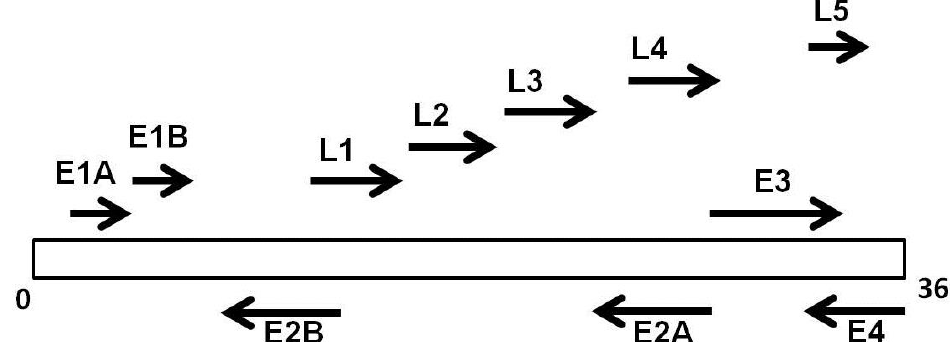
Figure 1. Genomic organization of Adv36: The early proteins (E1A, E1B, E2A, E2B, E3, and and E4) are involved in the regulation of replication of DNA. The late proteins E4) are involved in the regulation of replication of DNA. The late proteins (L1–L5), products of the translation of late mRNA, constitute structural capsid proteins.